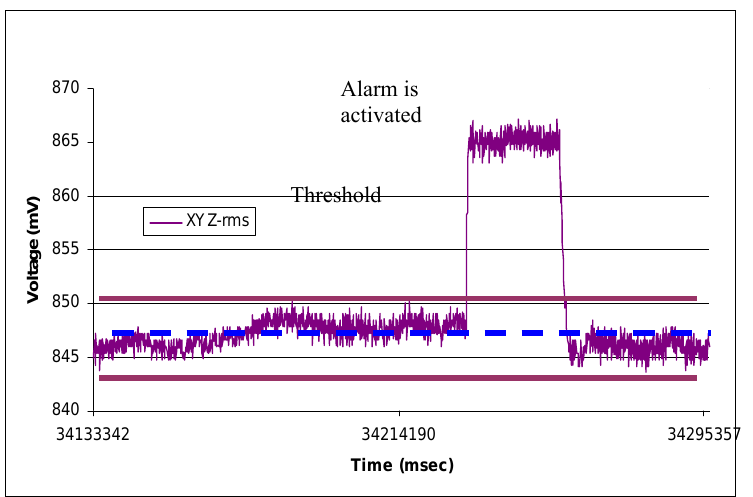
xyz )(  during a typical treatment session. Figure 8. rms